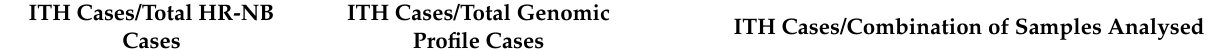
Table 1. Intratumor heterogeneous (ITH) cases according to total high-risk neuroblastomas (HR-NB) studied, their genomic profile (MYCN non-amplified, non-MNA; MYCN amplified, MNA; or with heterogeneous amplification of MYCN, hetMNA) and the combination of samples analysed in each